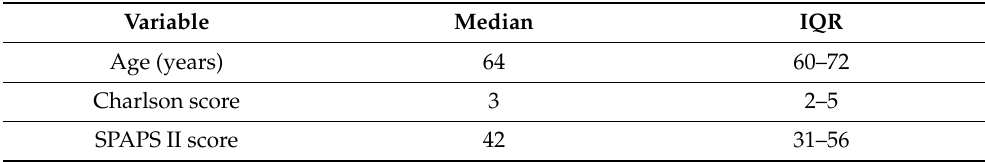
Table 3. Descriptive analysis of the